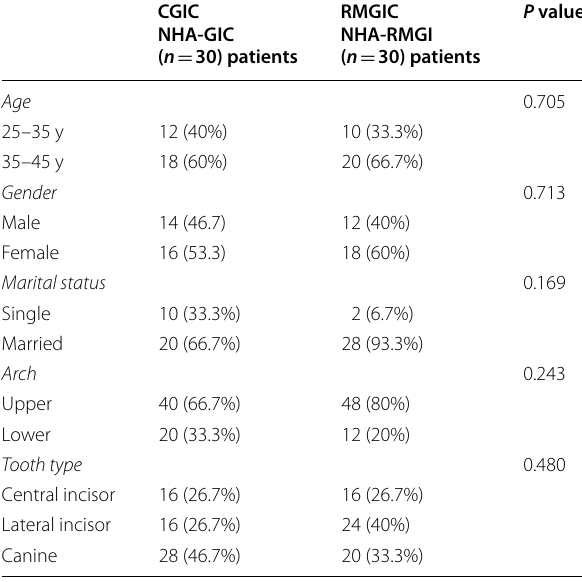
Table 4 Frequencies, percentages (%) and results of the Chi- square test for comparison of demographic data of the two main